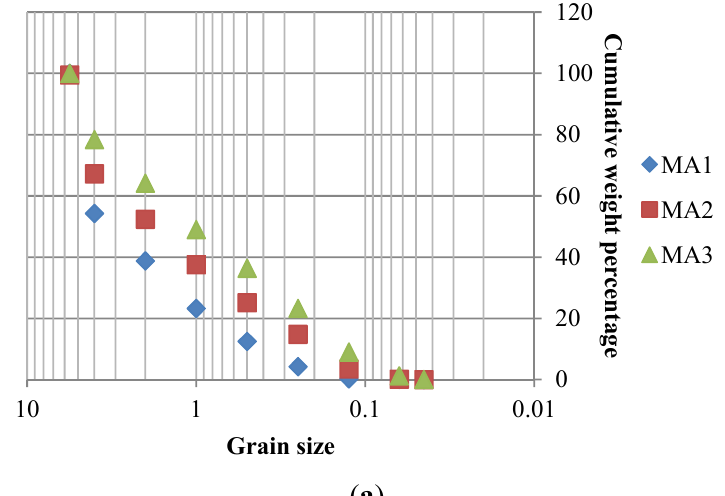
Figure 4. ( a ) Grain size distribution of samples MA1 to MA3. ( b ) Grain size distribution of samples MA4 to